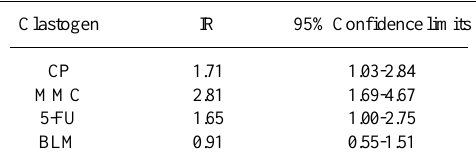
Table III - Increasing rates (IR) of micronucleus frequencies from 2-7 days after treatment with CP, MMC, 5-FU and BLM. Clastogen